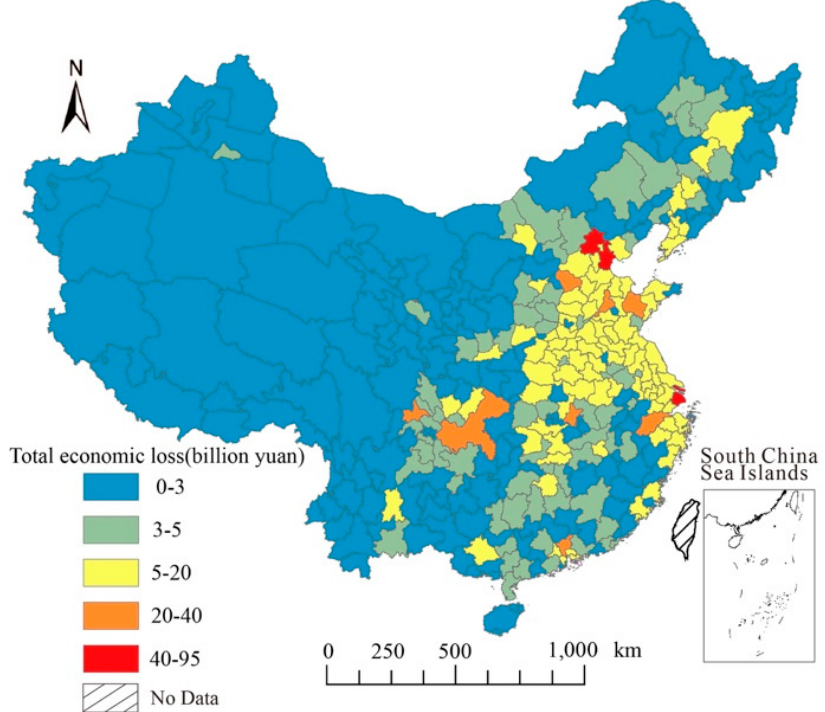
Figure 5. Spatial distribution of total economic loss in 338 Chinese cities.